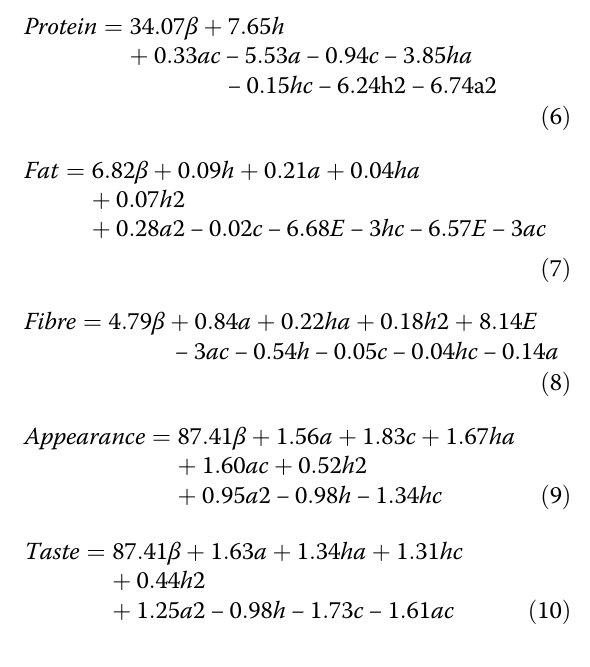
higher than 4. Figure 2 shows the response surface plots for the chemo-sensory parameters. Figure 2a, b, and e show that an increase in the amount of high-protein soymeal in the formulation improved the protein, fat, and appearance of the consumer-ready flakes. Figure 2c, d, and f show that the fibre, taste, and acceptability index of the flakes were favoured by the addition of more am- aranth flour in the formulation.